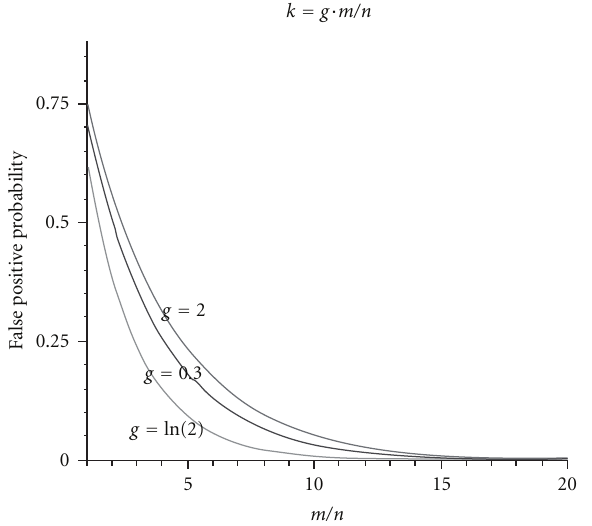
Figure 2: False positive probability for di ff erent